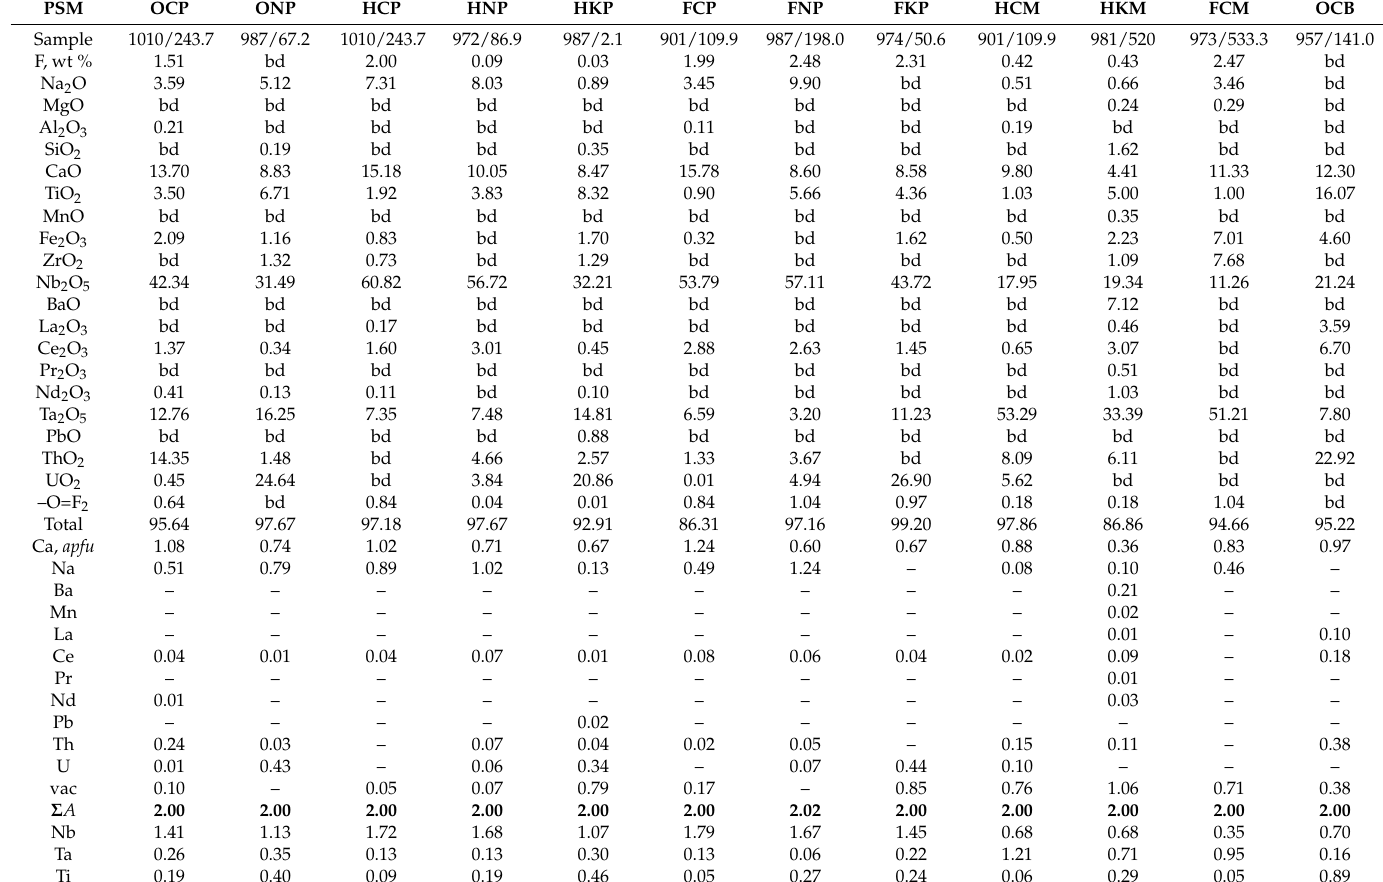
Table 3. Precision microprobe analyses of pyrochlore supergroup minerals (wt %) (see abbreviations above) and the corresponding crystallochemical formulas calculated on the basis of B = 2, X = 6 and Y = 1 atoms per formula unit ( apfu